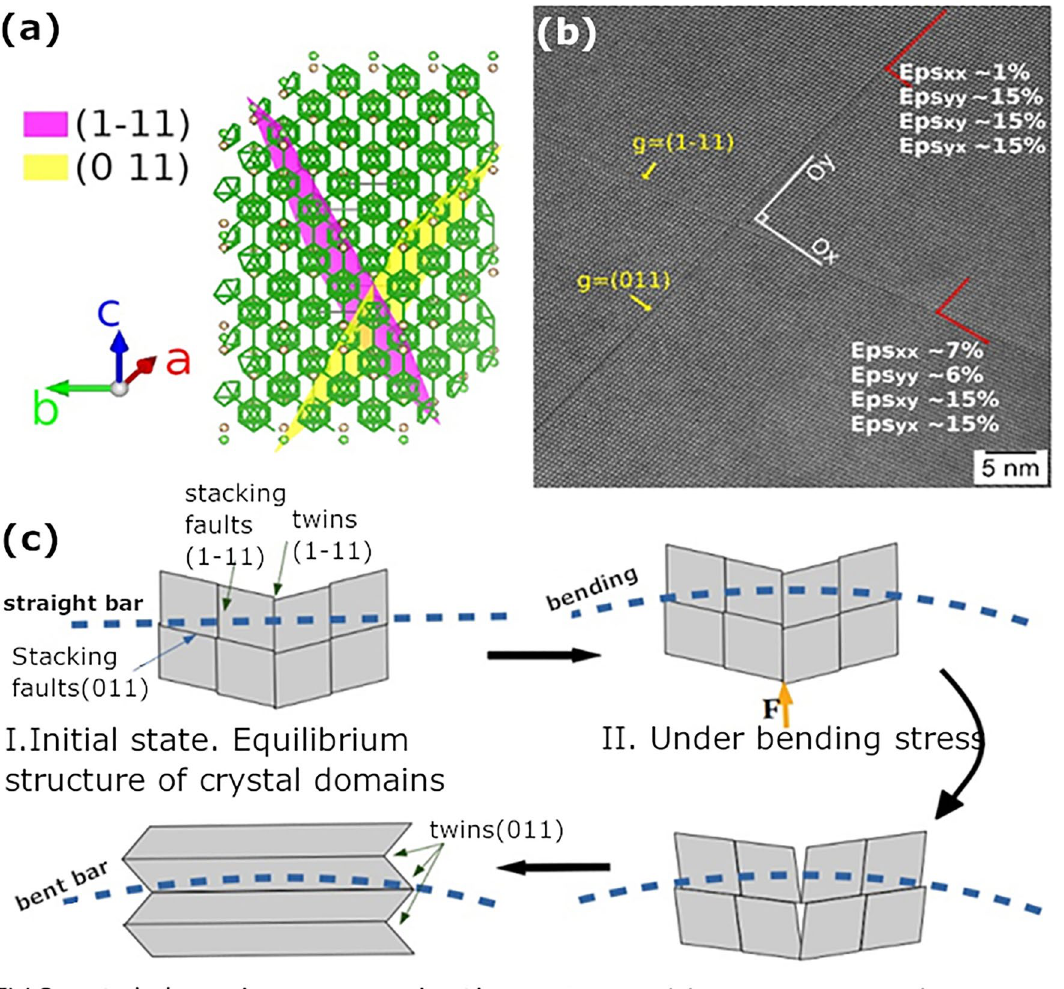
Figure 5. ( a ) Boron carbide crystal representation by VESTA software showing equivalent planes (1-11) and (011); ( b ) HRTEM image taken on sample E showing strain components with Oy being parallel to (011) planes; ( c ) Schematics of the transition under bending load between a twinned and stacking faulted structure as in sample E to a nano-twinned one as in sample